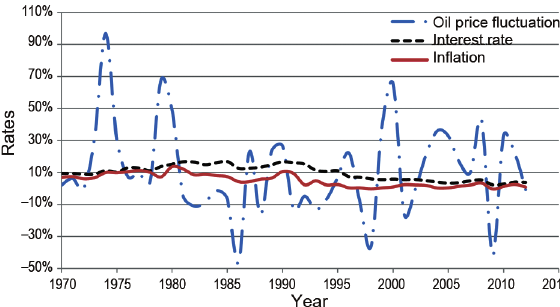
Fig. 1. The yearly average crude inflation, lending interest rate (World Bank 2012) and inflation for Sweden